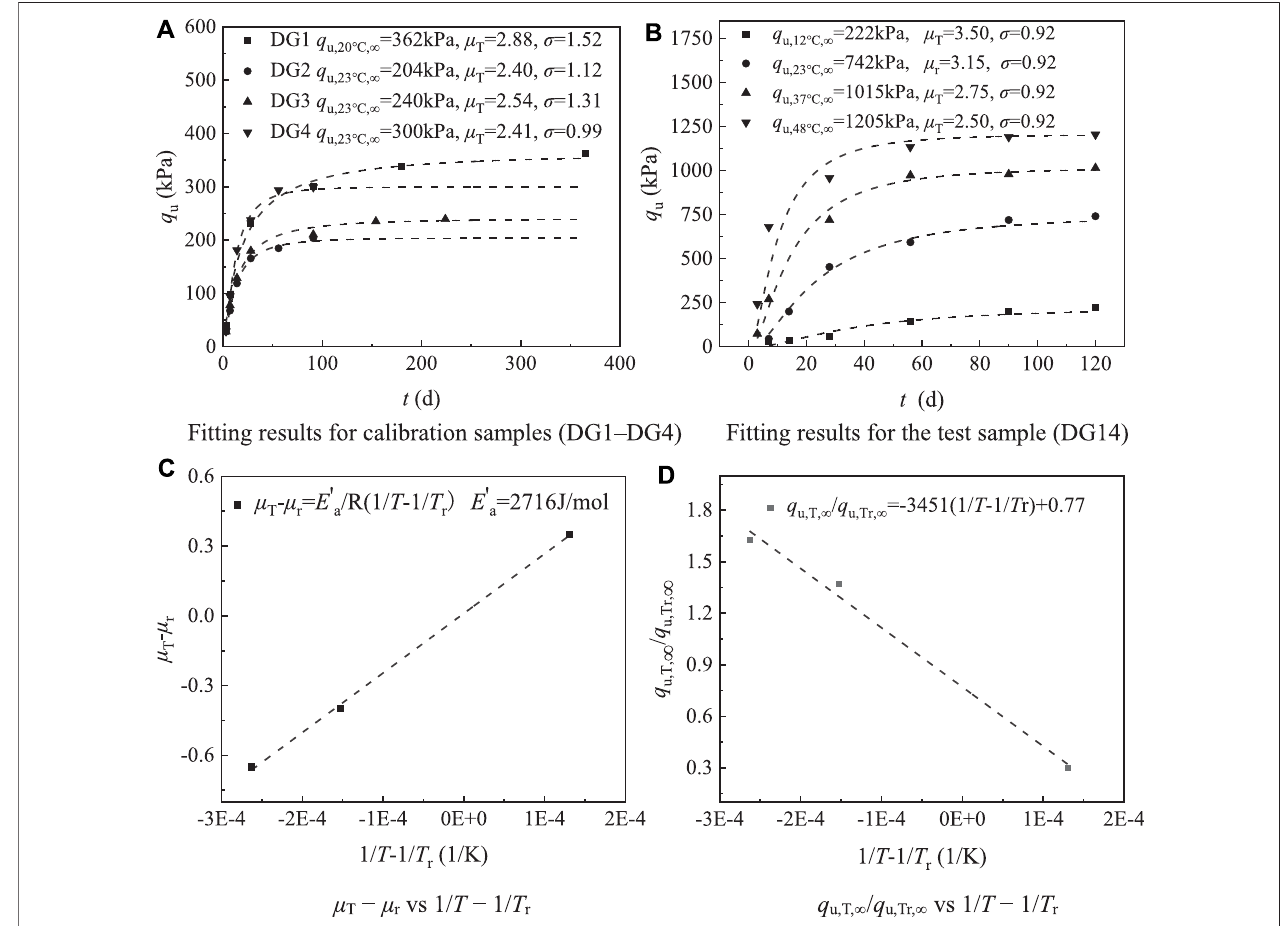
FIGURE10| Veri fi cationofthemodelusingdatafromZhangetal.(2014). (A) Fittingresultsforcalibrationsamples(DG1 – DG4) (B) Fittingresultsforthetestsample (DG14) (C) μ T − μ r vs. 1/ T − 1/ T r (D) q u,T, ∞ / q u,Tr, ∞ vs. 1/ T − 1/ T r .